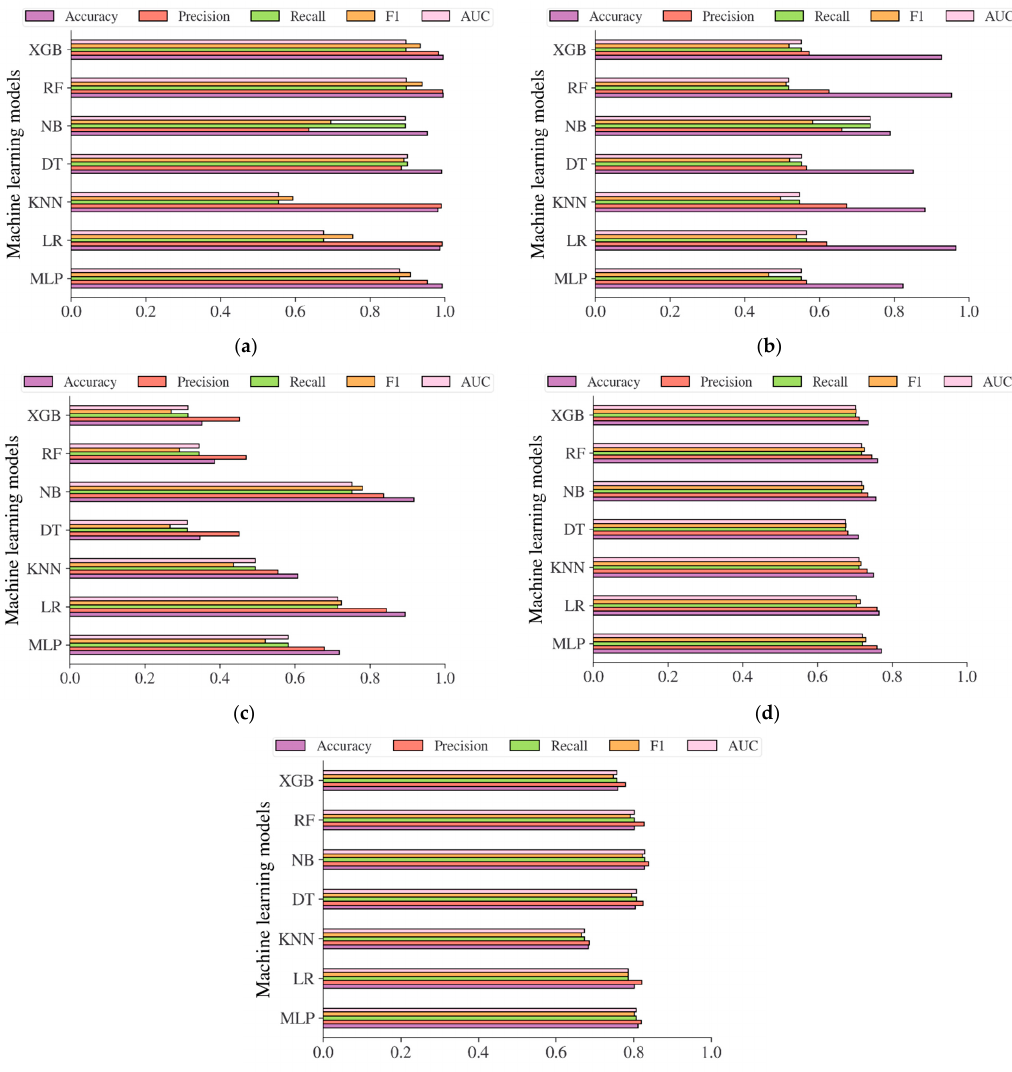
Figure 12. The results of diabetes prediction based on machine learning models on ( a ) Chinese, ( b )